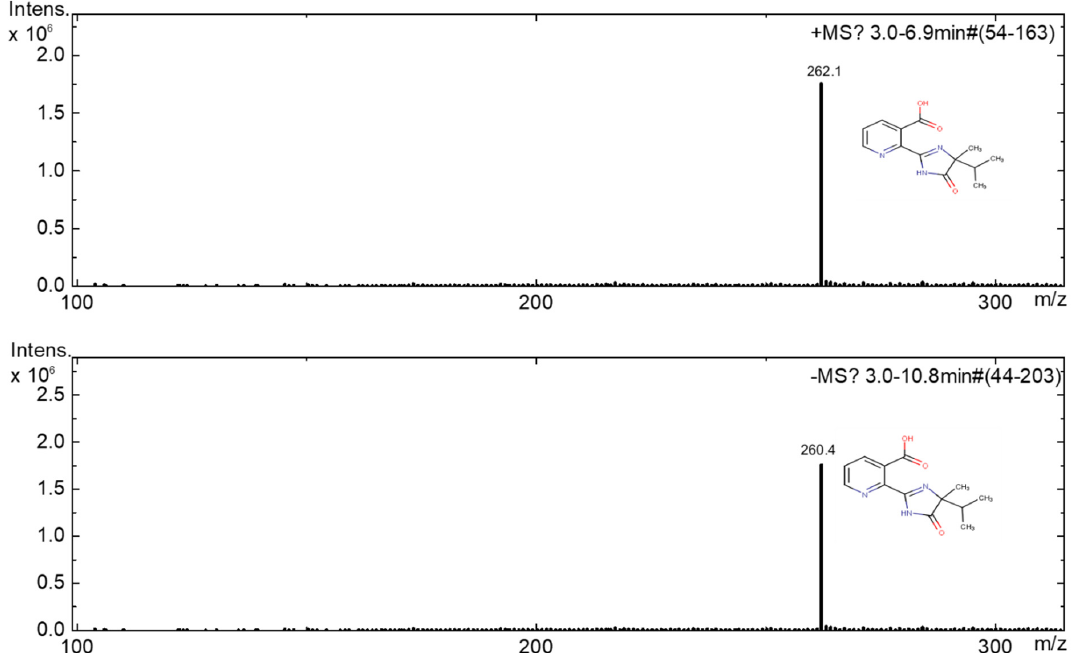
Table 2. photoproducts of Imazapyr degradation and their intensities identified by the positive and negative modes of MS-ESI.